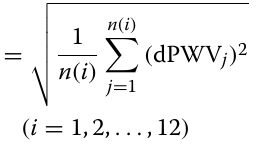
the Uji network, we calculated the root-mean-square (RMS) values of PWV using the GNSS data observed by 15 GNSS stations around Uji, i.e., seven GEONET sta- tions inside the circle in Fig. 1a and eight GNSS stations of the Uji network. The RMS values were calculated every